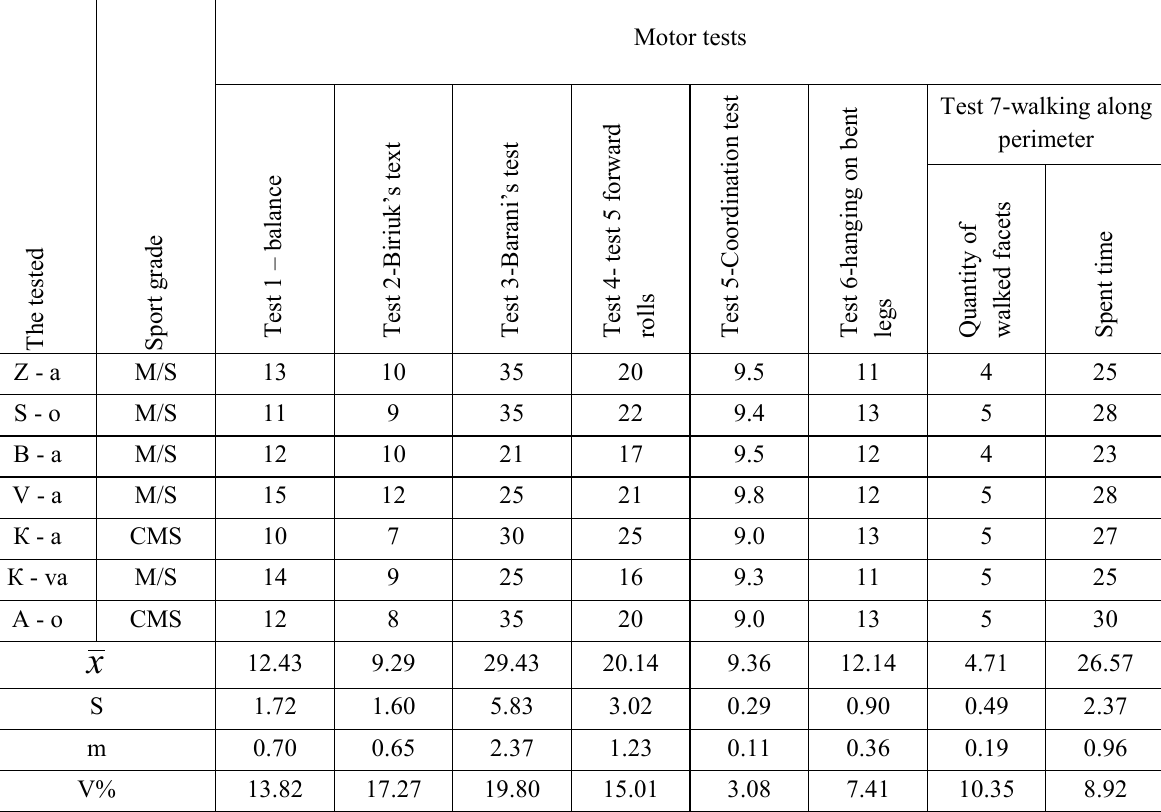
Initial indicators of sensor-motor coordination of first year girl students (NUPESU), specializing in sport gymnastic